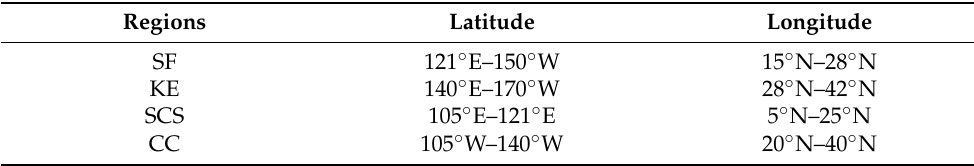
Figure 1. Mean value of EKE during 1993 to 2019. The black lines delineate the four study regions. Table 2. Research regions and their geographical ranges.